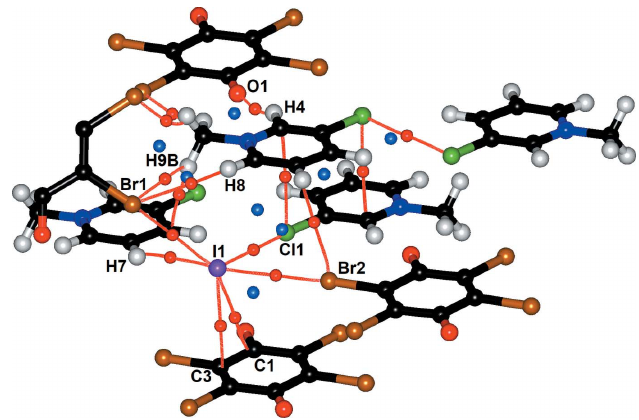
Figure 5 Symmetry-independent intermolecular critical points in 1 . (3, (cid:3) 1) critical points are shown as red spheres and (3, +1) critical points as blue spheres in the interatomic space; bond paths are shown as red lines.